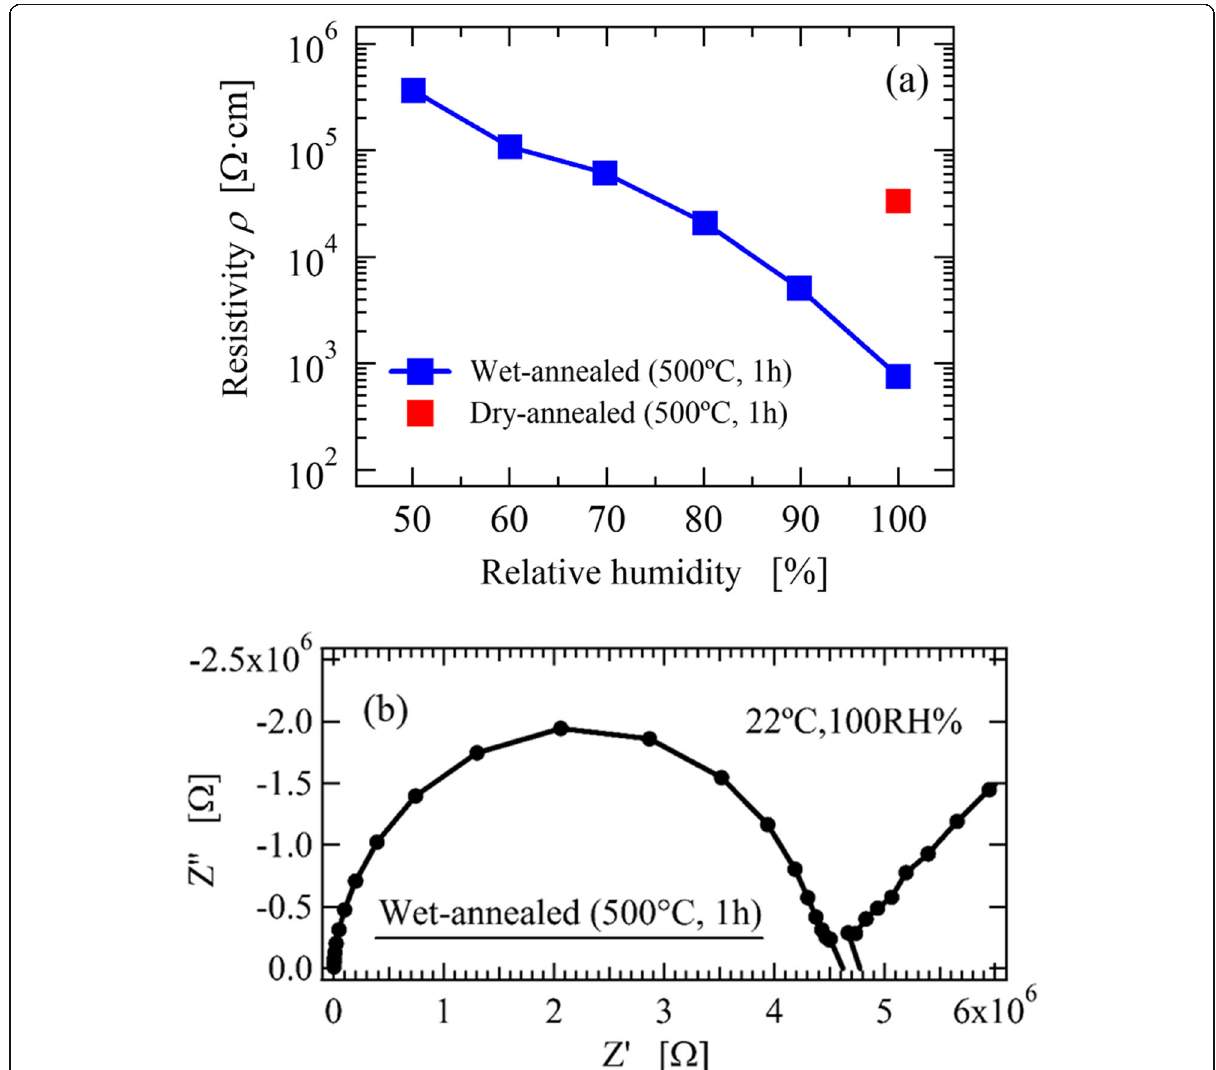
Fig. 4 a The relative humidity dependence of the wet-annealed SDC thin film and b Cole-Cole plots of the wet-annealed SDC thin film, measured in 100 RH% wet air at 22